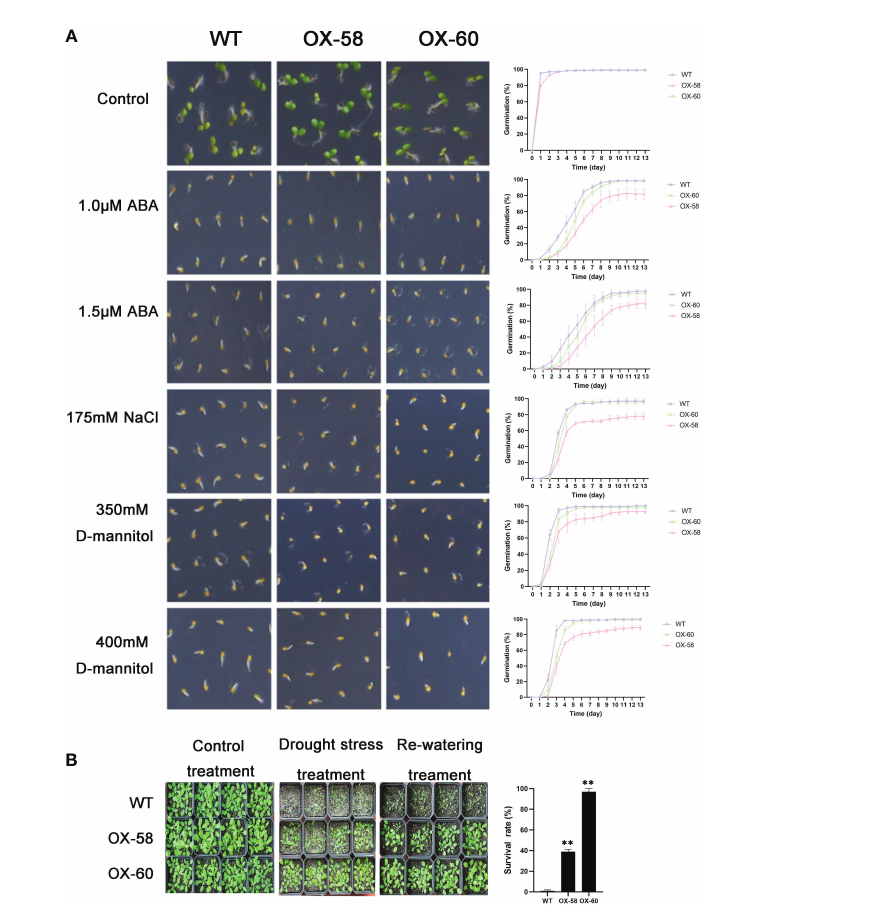
FIGURE 9 Germination and phenotype analysis ZmNAC87 overexpressing Arabidopsis . (A) Germination assays of ZmNAC87 were performed under